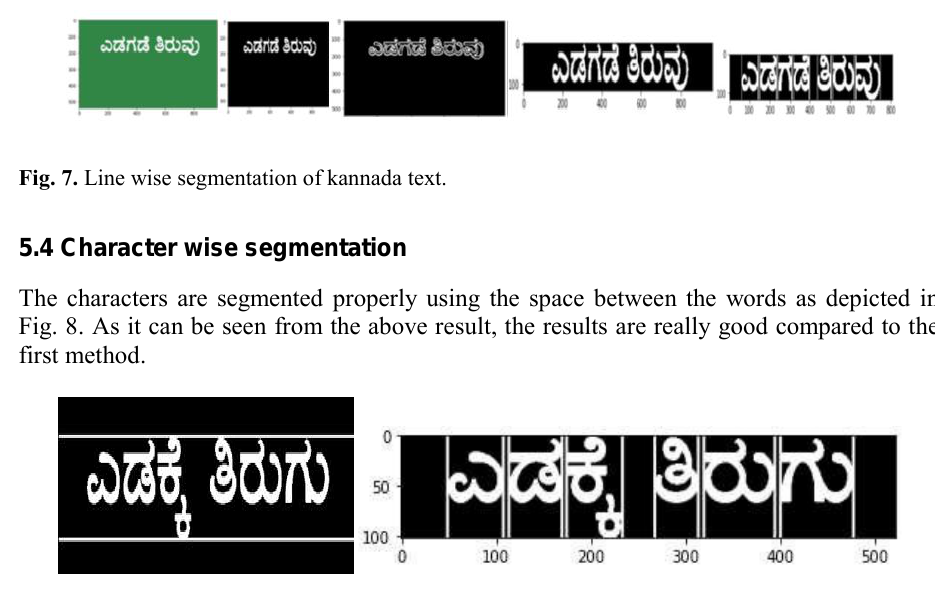
Fig. 8. Character wise segmentation of kannada text.